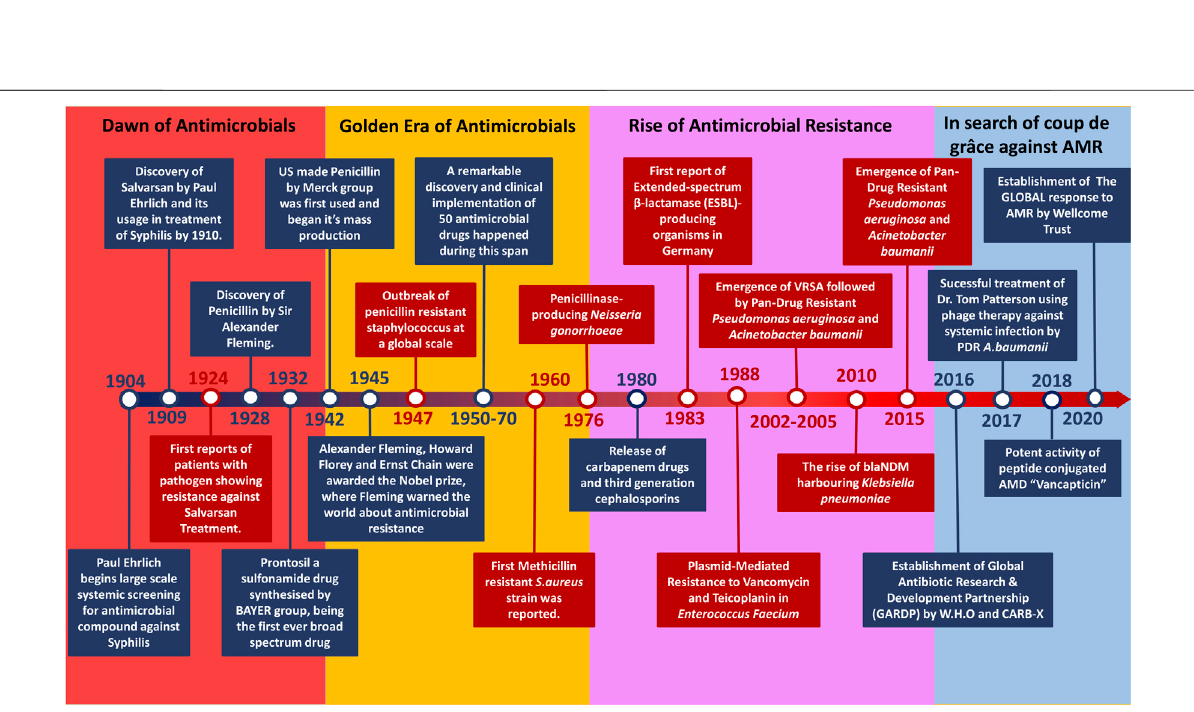
FIGURE 1 | Schematic representation of AMDs distribution according to their targets: There are 13 signi fi cant classes of AMDs that target different types of machinery and aspects of the microbe, ranging from DNA synthesis to cell wall synthesis. The majority of the AMDs marked in yellow (O) box belong to the Golden Era.